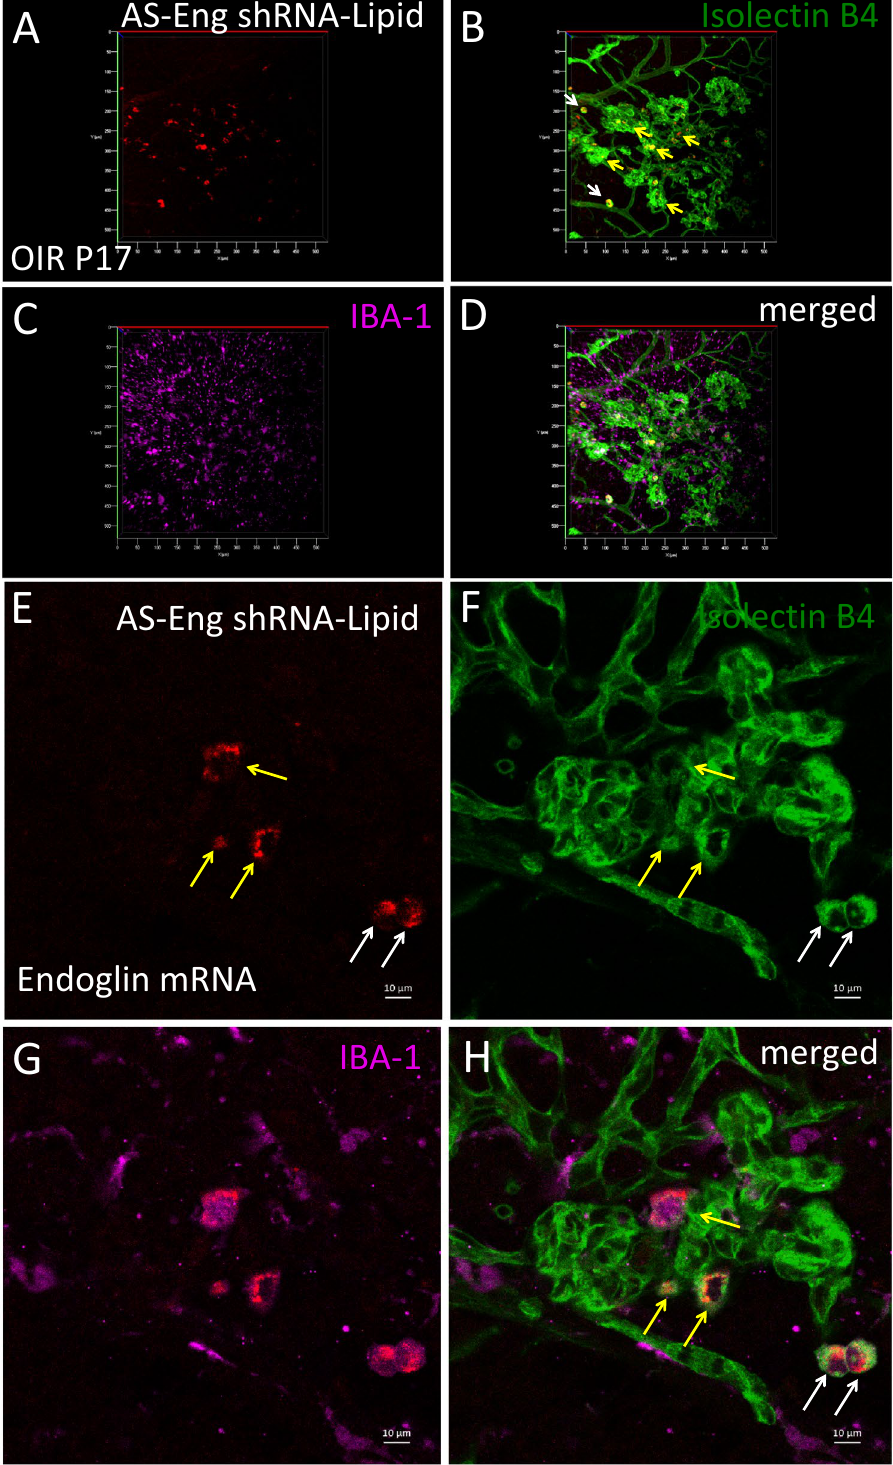
Figure 4. Ex vivo validation of AS-Eng shRNA–lipid fluorescence localized with IBA1 positive cells that are associated with neovascular tufts in mouse P17 OIR retina. Isolectin B4 was used to visualize the retinal vasculatures. ( A – D ) Showing shRNA–lipids are associated with neovascularization and not in normal vasculatures. The OIR mice received intraperitonel injections of AS-Eng shRNA–lipid conjugates. Eighteen hours post-injection, retinal tissues were analyzed ex vivo. AS-Eng shRNA–lipid fluorescence was localized in IBA1 positive cells (arrows), suggesting that endolgin and IBA1 positive activated microglia/macrophages are associated with neovascularization 31 . ( E – H ) Showing shRNA–lipids are associated with IBA1 positive cells in neovascularization in the superficial capillary plexus. Strong fluorescence emission presumably due to hybridization with endoglin mRNA in these IBA1 positive cells localized around neovascularization, showing the probe delivery to the neovascular tufts. Minimal fluorescence was observed in the normal endothelial cells that are also positive for endoglin mRNA, suggesting that the probe hybridization might occur at the site away from these microvascular endothelial cells and migrated to the site of